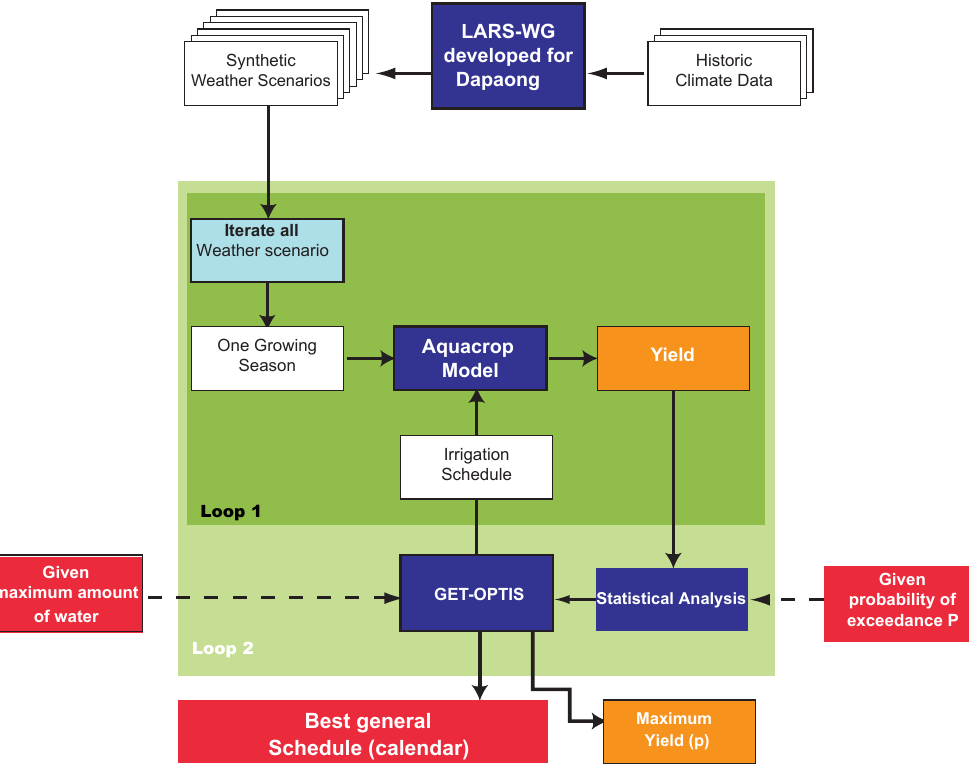
Figure 3. General framework for generating stochastic crop water production functions (adapted from Schütze and Schmitz